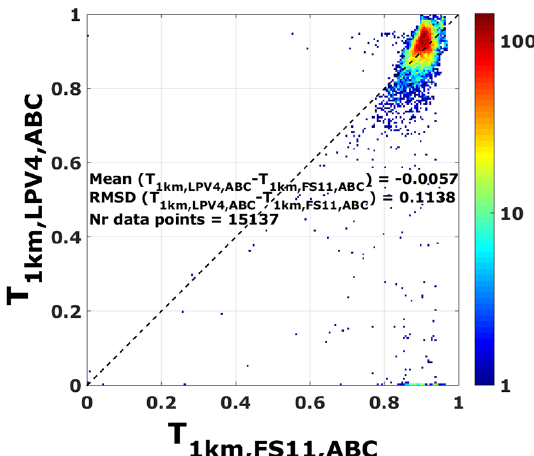
Figure 6. Absorption and broadband-corrected transmittance for 1km slant range measured by FS11 scatterometer and LPV4 trans- missometer. Color distribution displays the number of data points per grid point (logarithmic color scale).